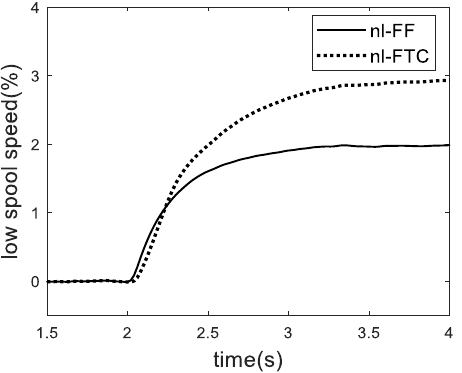
Figure 15. Comparison of low spool speeds in the HIL test.